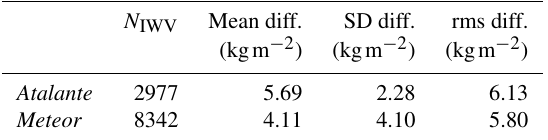
Table 7. Comparisons of IWV from R/Vs Atalante and Meteor to IWV from Maria S. Merian : N IWV – number of comparisons, mean, standard deviation and rms of differences. N IWV Mean